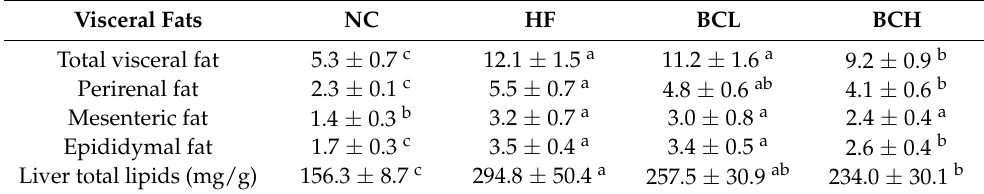
Table 2. Relative size of visceral fat pads (g/100 g body weight) and liver total lipids (mg/g) among different